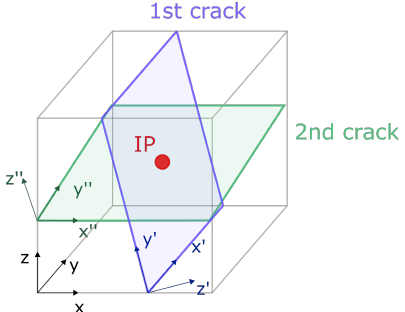
Figure 6. Local coordinates systems associated with